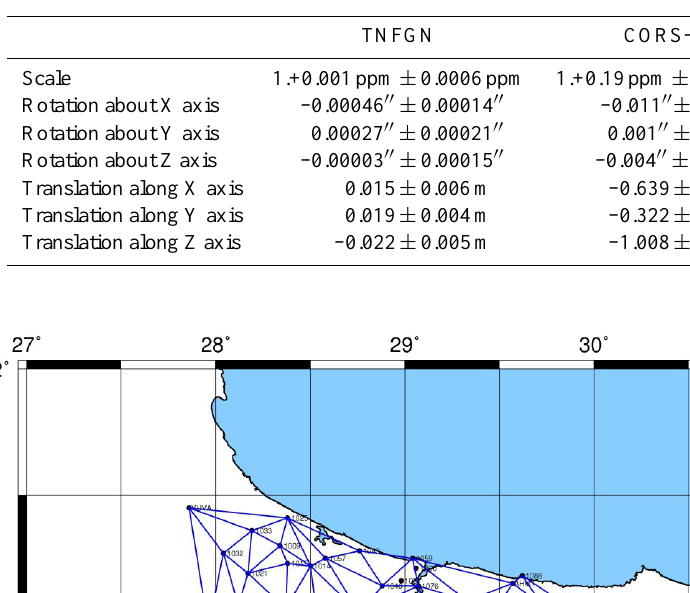
Table 4. Transformation parameters of epoch 2000.45 and 2006.60.